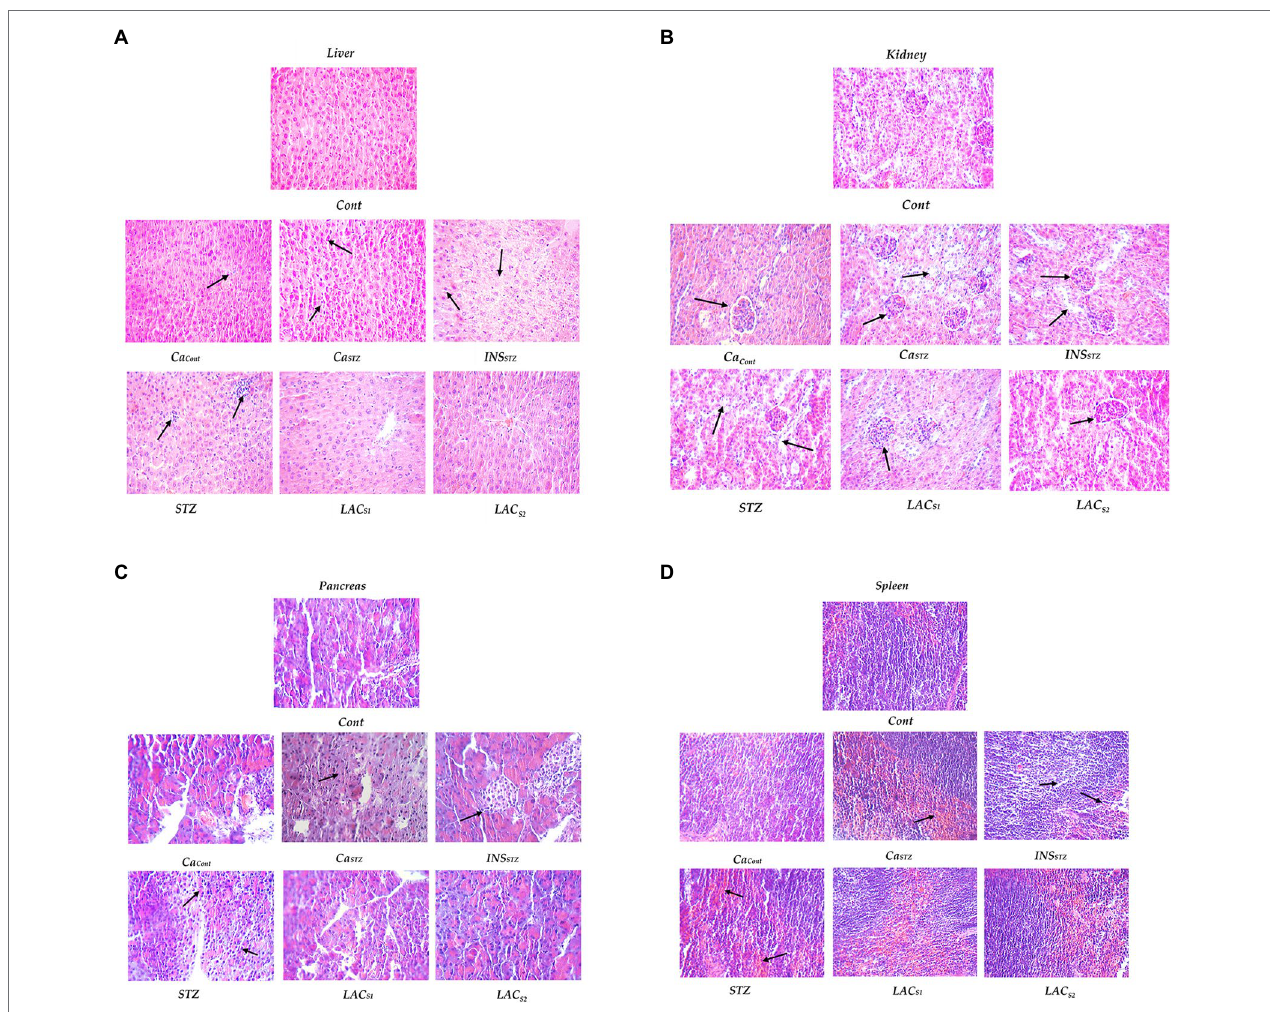
FIGURE 7 | Histopathological evaluation. Cont , control; Ca Cont , camel milk control; Ca STZ , camel milk with streptozotocin; INS STZ , insulin with streptozotocin; STZ , streptozotocin; LAC SI , KLDS 1.0727 with streptozotocin; LAC S2 , KLDS 1.0373 with streptozotocin. (A) Lever; (B) ) Kidney; (C) Pancreas and (D)